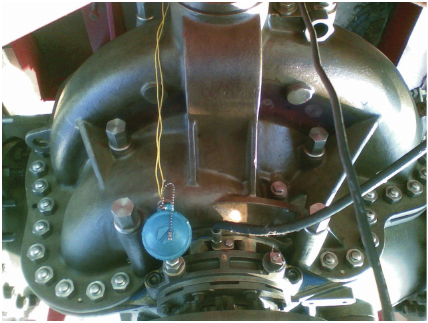
Figure 6: The prototype of centrifugal pump corresponding to the optimization